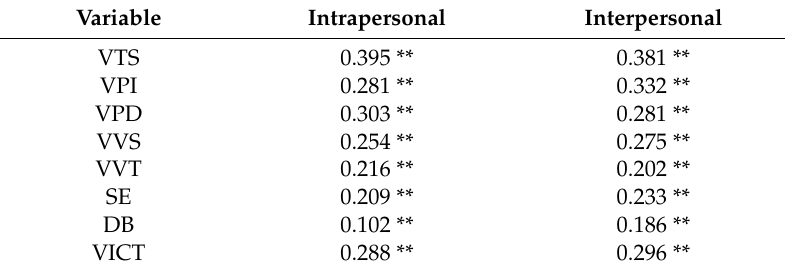
Table 1. Pearson Correlation between the variables of